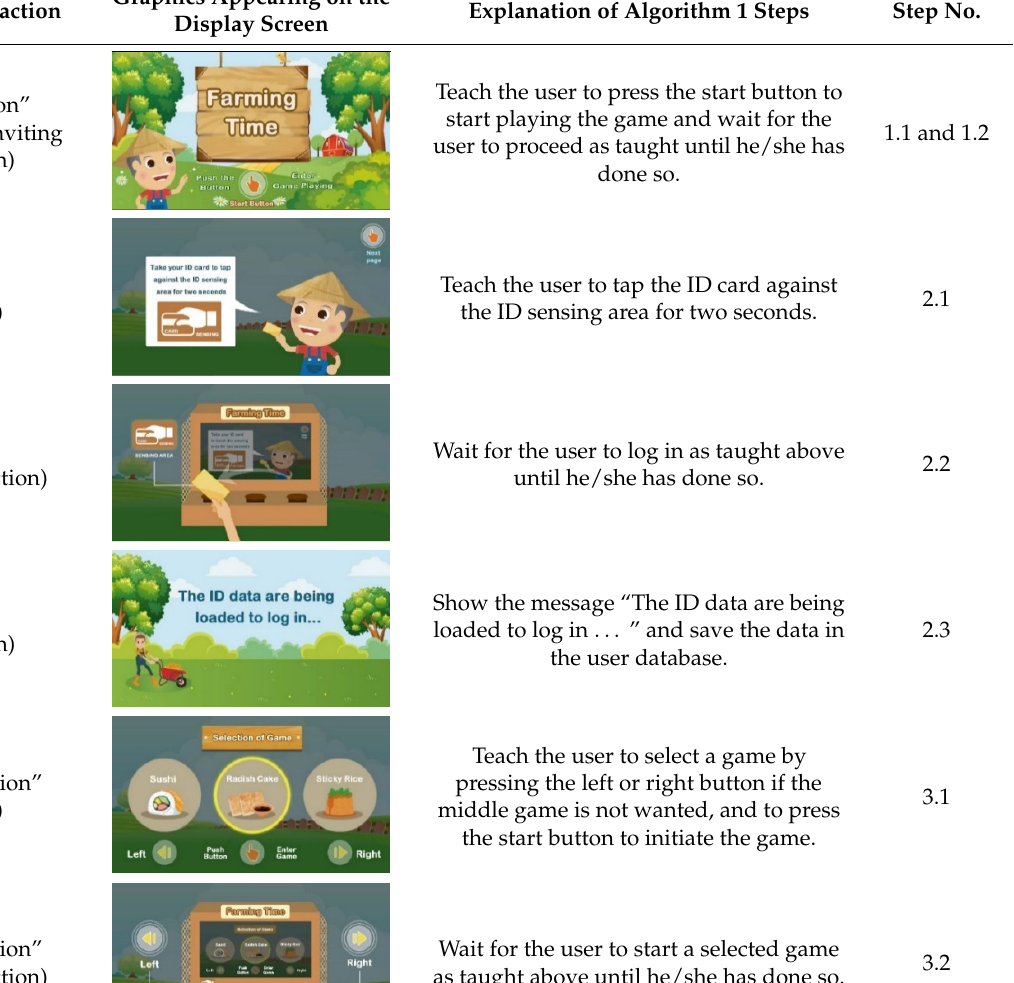
Table 4. A graphic illustration of an example of running the game playing process of the algorithm on the proposed system (from the viewpoint of the system using graphic pictures).